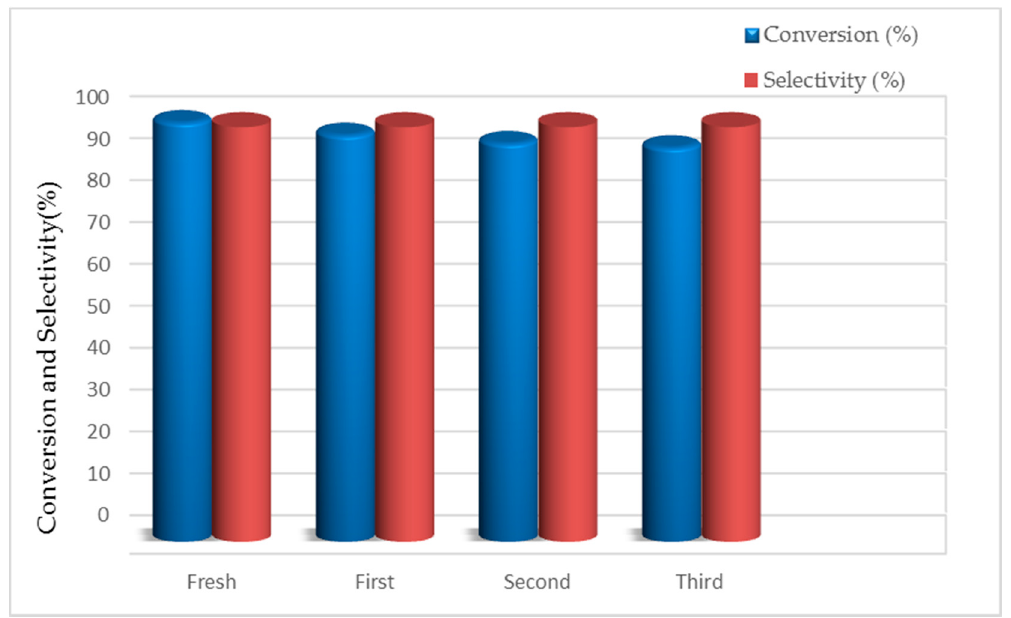
Figure 1. Cycling performance of MK10 in the synthesis of trans -4,5-dimorpholinocyclopen-2-enone under MW irradiation.